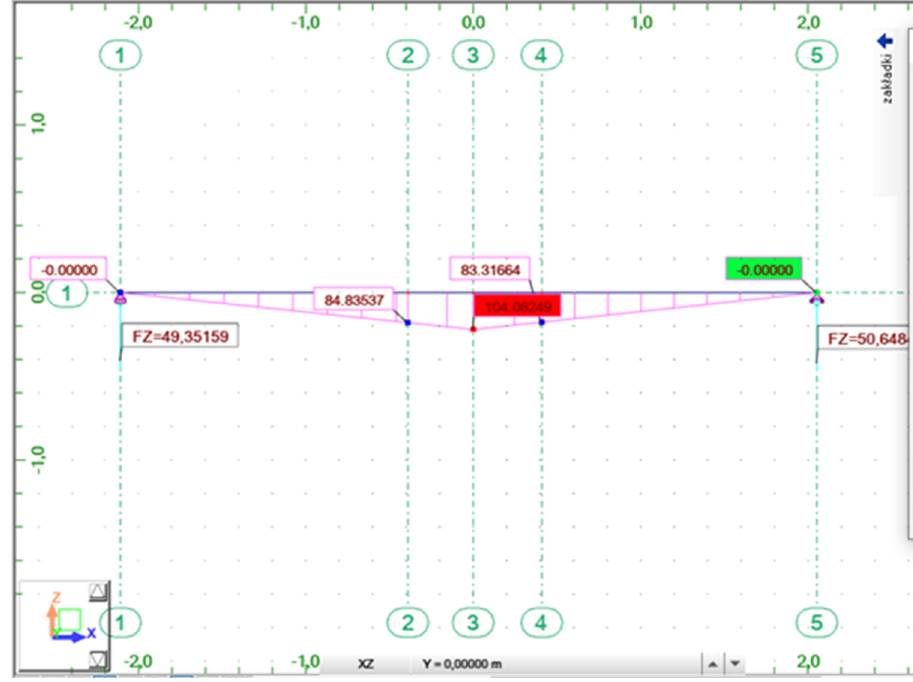
Figure 14. Bending moment of the main beam with an increased stiffness in the central part.